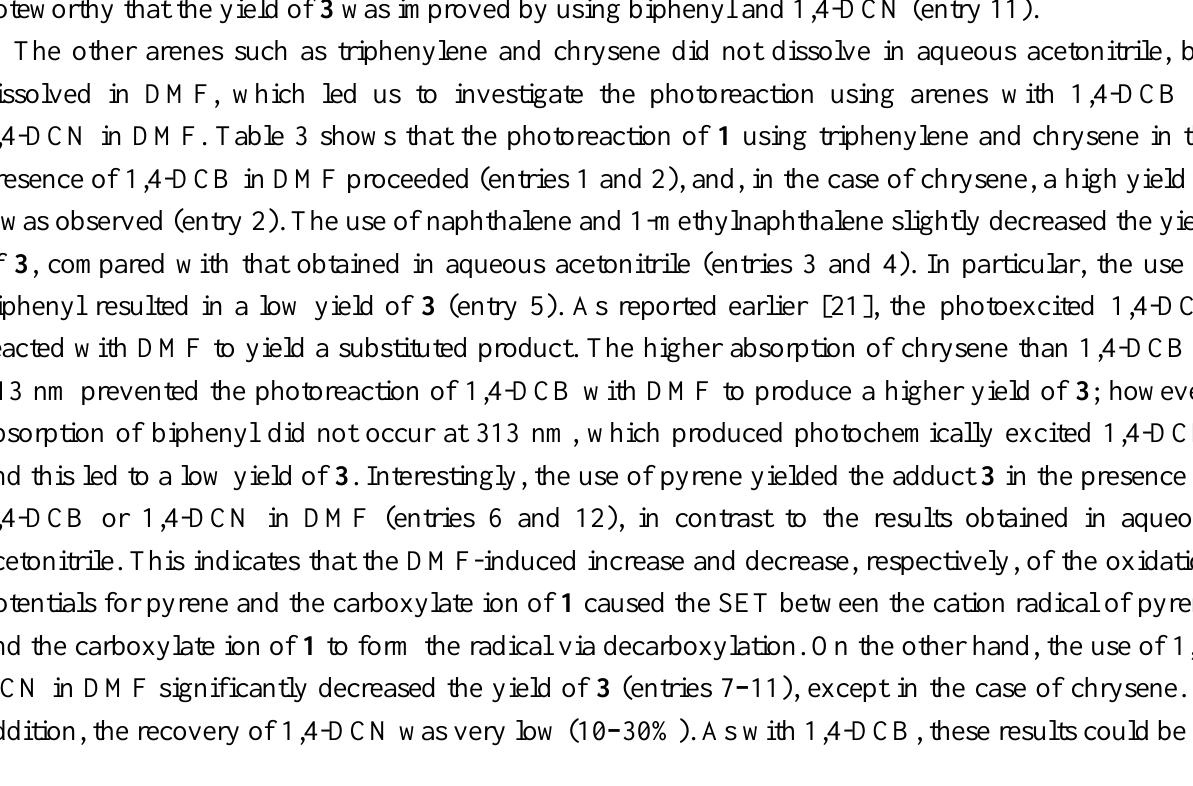
Table 3. Photoreaction of 1 and 2 using several arenes and electron acceptors in